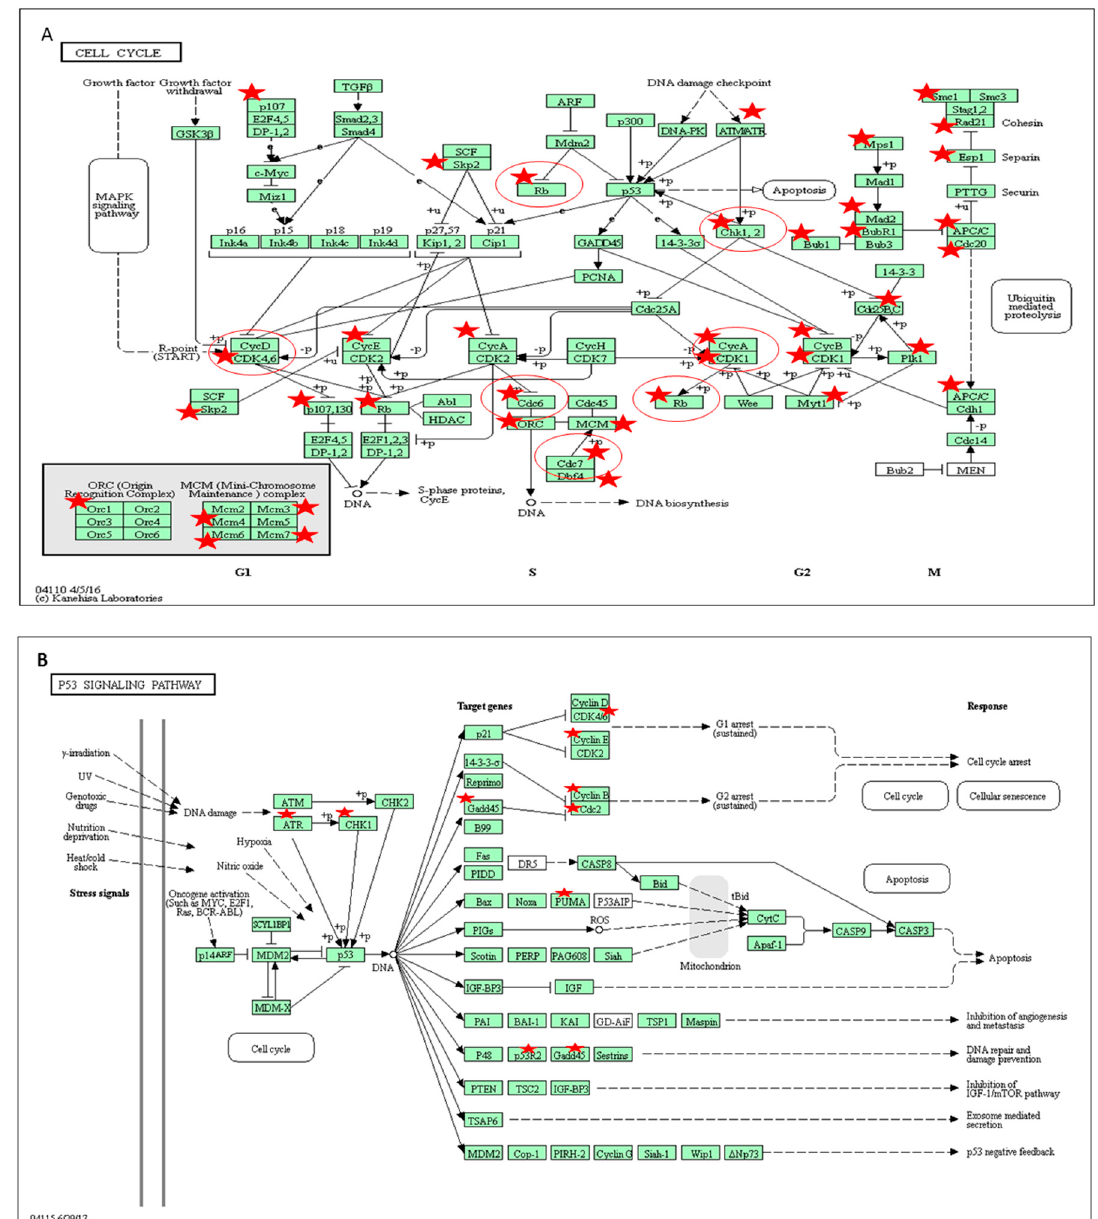
Figure 6. KEGG and BioCarta pathways of proteins encoded by genes related to cell cycle and ROS whose expression was altered in BS-24-1 cells after treatment with ethyl acetate extract of A. graveolens ( A ) and ( B ) Kegg cell cycle pathway and p53 pathway, respectively. In panel ( A , B ), red stars represent the genes whose expression was altered by treatment with A. graveolens extract while red circles represent cancer-related genes.